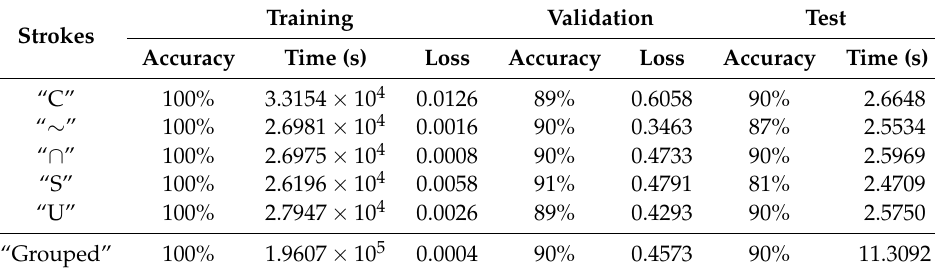
Table 5. Rectified Simple Grapheme - VGG-16 (epoch = 80).